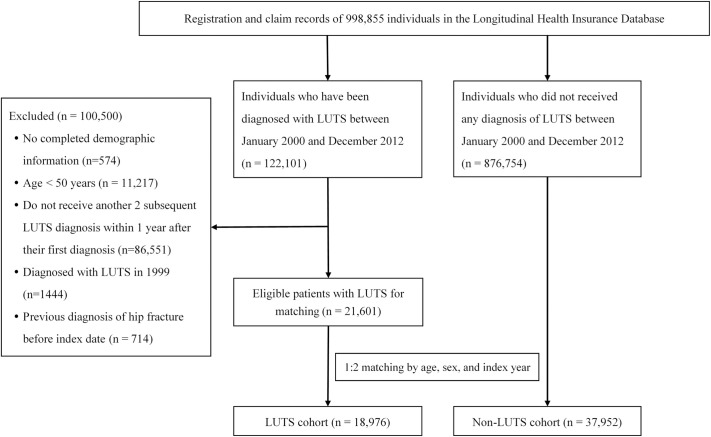
Study flow chart.